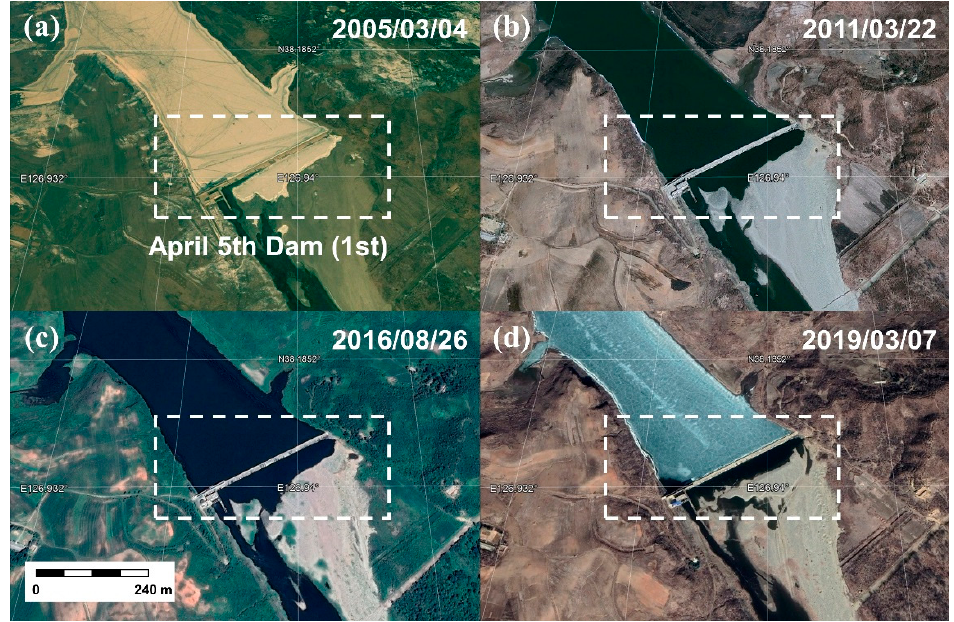
Figure 2. Images of the First April 5th Dam from 2005 to 2019 (Lat 38.1816° N, Lon 126.9389° E, map data © 2019 Google, Maxar Technologies).